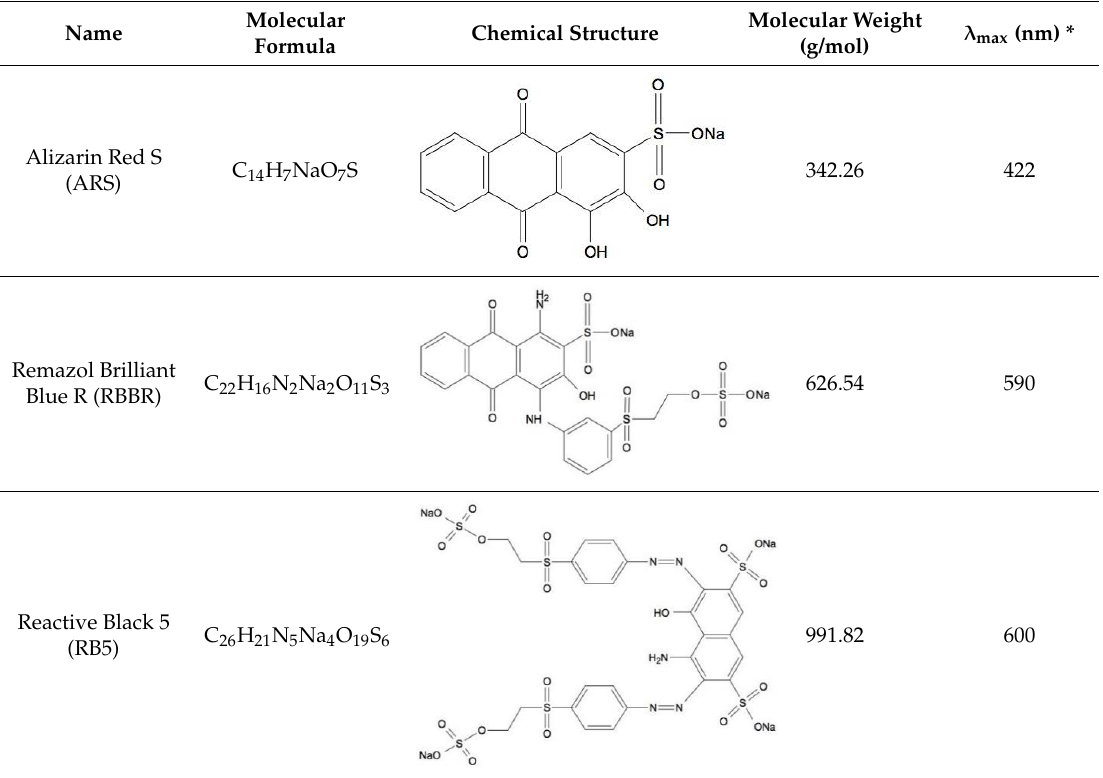
Table 6. General characteristic of the dyes used in the study. * based on own measurements.